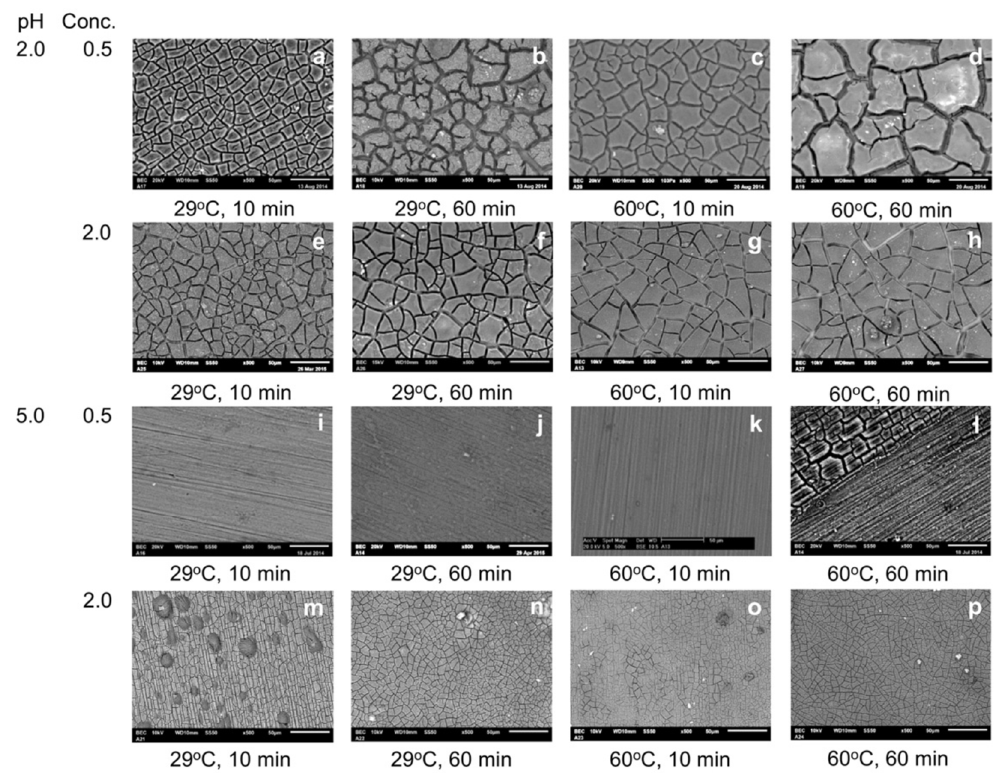
Figure 16. SEM images of the phytate conversion coatings on the AZ31 alloy samples treated in phytic acid solutions, varying pH, phytic acid concentration, treatment time, and temperature. Reprinted from [324] with permission from Elsevier.